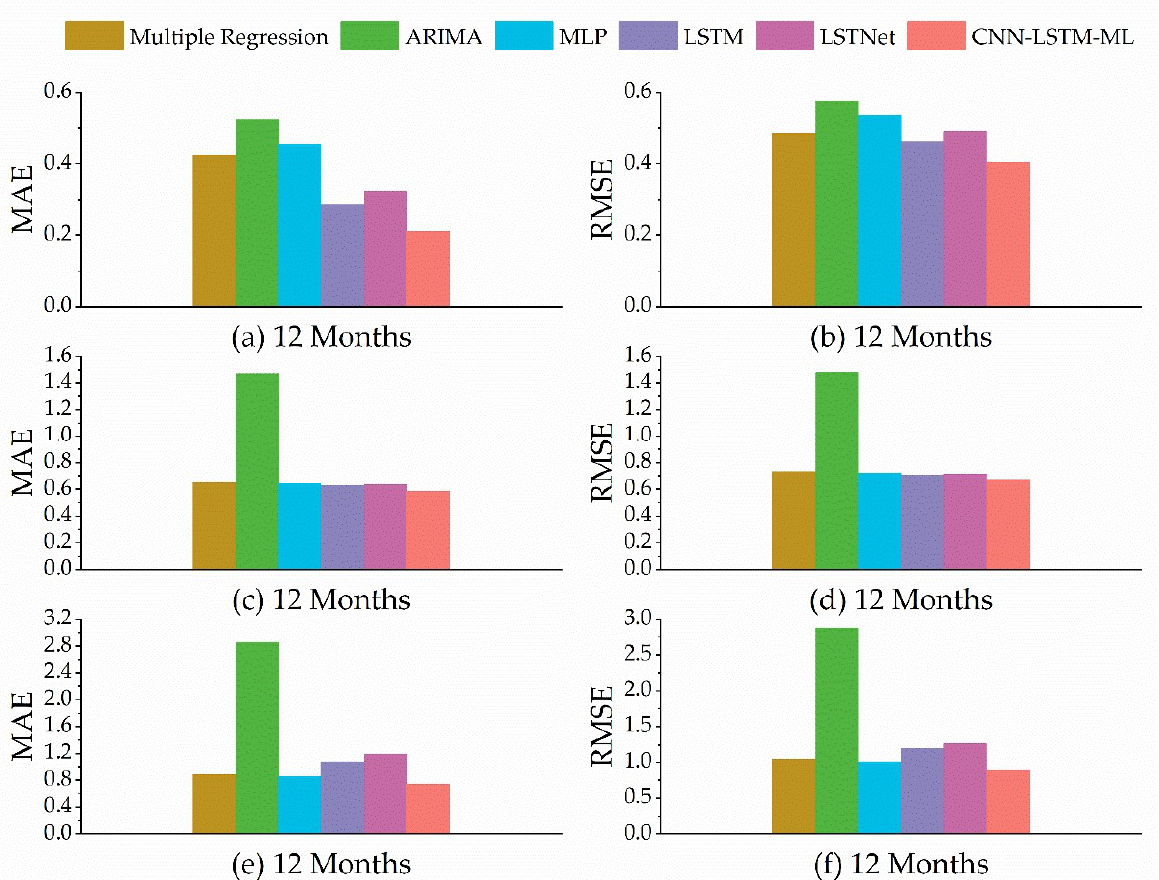
Figure 9. Average RMSE and MAE of models using different amounts of training data. ( a , b ) reduce training data by 10%. ( c , d ) reduce training data by 30%. ( e , f ) reduce training data by 50%.